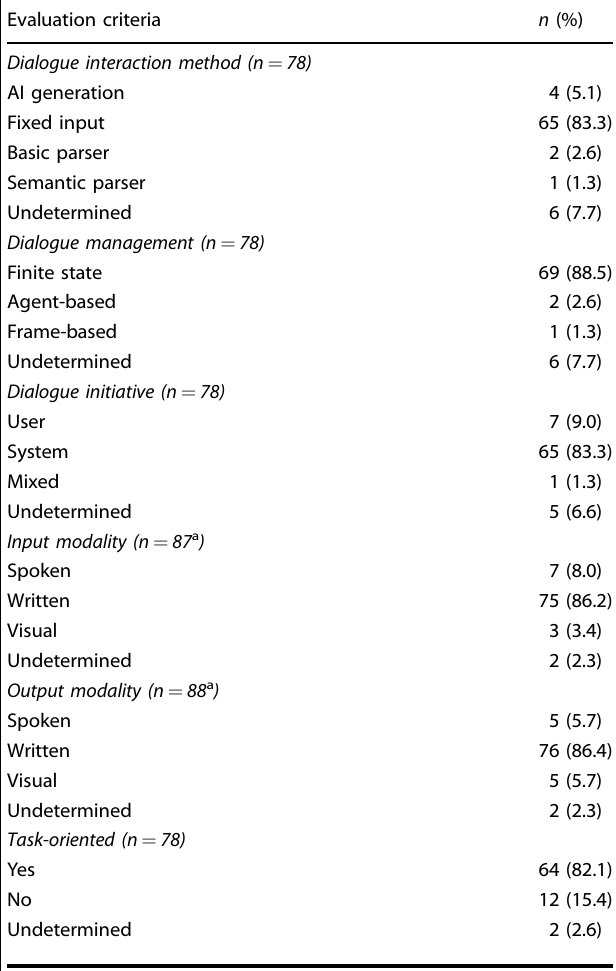
Table 2. Characterization of NLP system design.